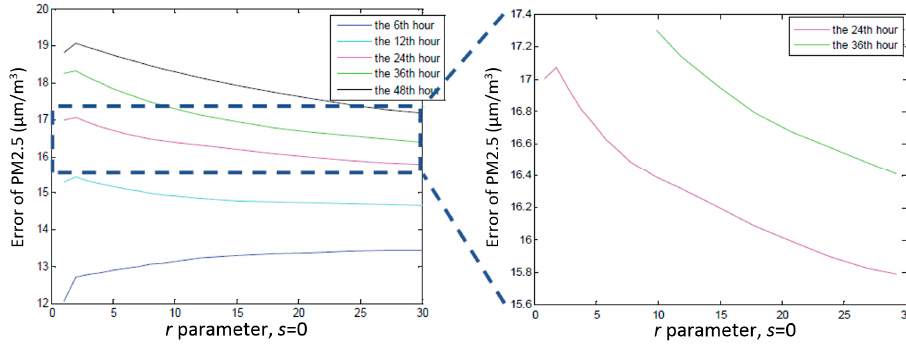
Figure 8. The impact on PM2.5 error of parameter r on the PM2.5 value forecast.